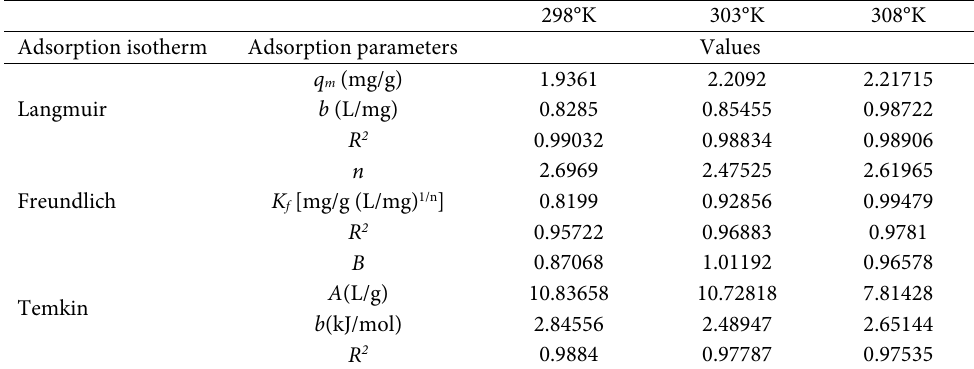
Table 3. Parameters of adsorption isotherms for Cu (II) on